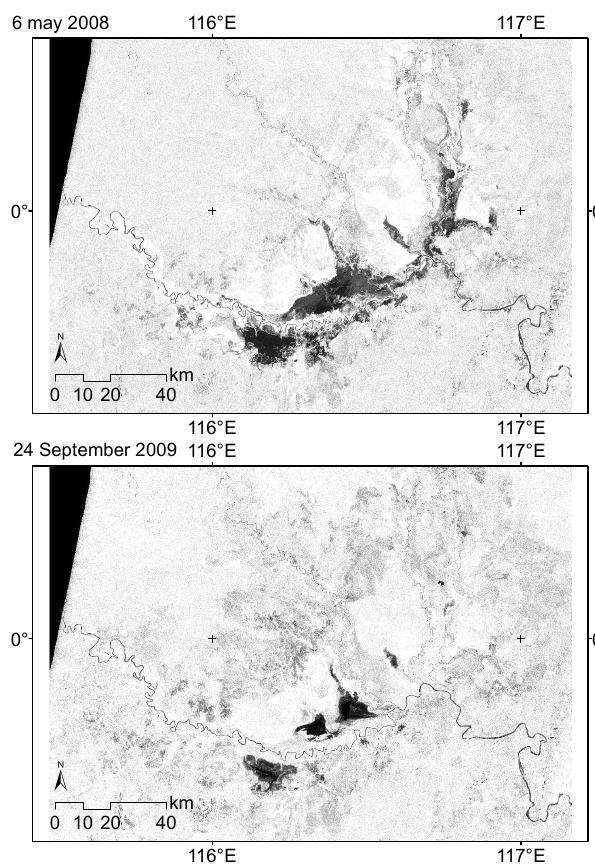
Fig. 4. PALSAR images of the middle Mahakam area during a wet season (top) and a dry season (bottom). Dark areas indicate open water extent, bright areas indicate inundation under vegetation cover.